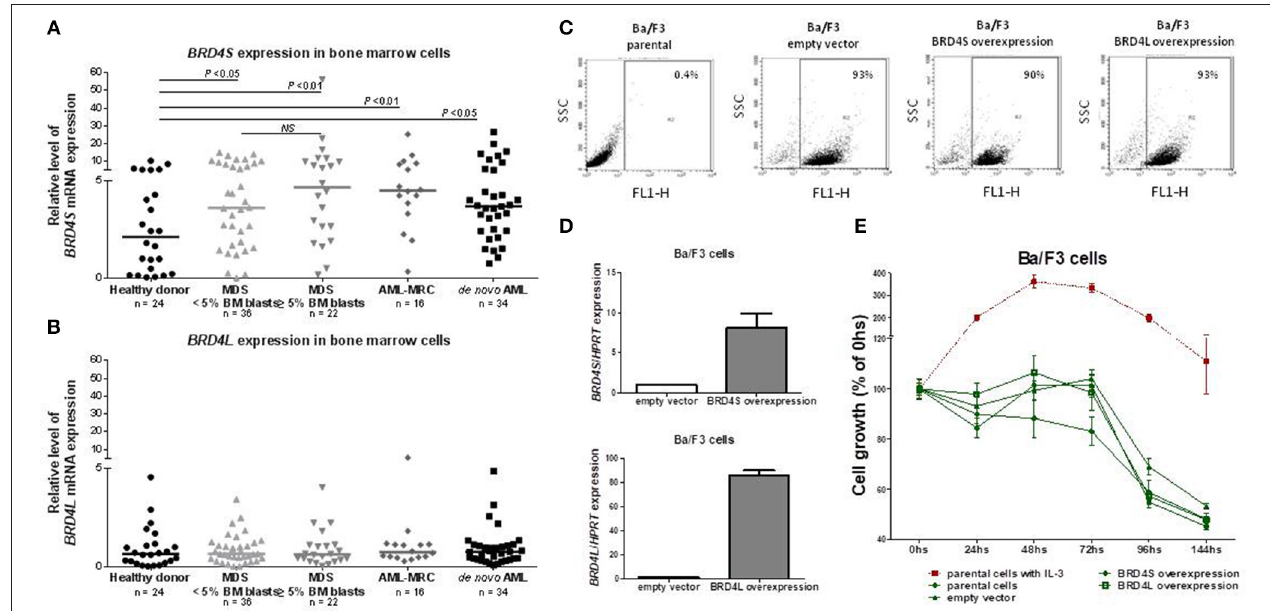
FIGURE 1 | BRD4 short variant gene is overexpressed in MDS and AML patients. BRD4S mRNA expression in total bone marrow cells from healthy donors, MDS < 5% BM blasts, > 5% BM blasts, AML-MRC and de novo AML patients (A) ; BRD4L mRNA expression in total bone marrow cells from healthy donors, MDS < 5% BM blasts, > 5% BM blasts, AML-MRC, and de novo AML patients (B) ; Efficiency of GFP-positive BA/F3 cells transduced with empty vector, BRD4S and BRD4L , in that order, measured by flow cytometry (C) and by quantitative PCR (D) ; (E) Comparative growth (normalized by the initial number of cells) of BA/F3 parental cells (with and without IL-3), control (empty vector) or transduced with full-length BRD4S or BRD4L . The number of subjects and significant P- values (Mann–Whitney test) are indicated in the graph. MDS, myelodysplastic syndromes; AML, acute myeloid leukemia; AML-MRC, acute myeloid leukemia with myelodysplastic related changes.